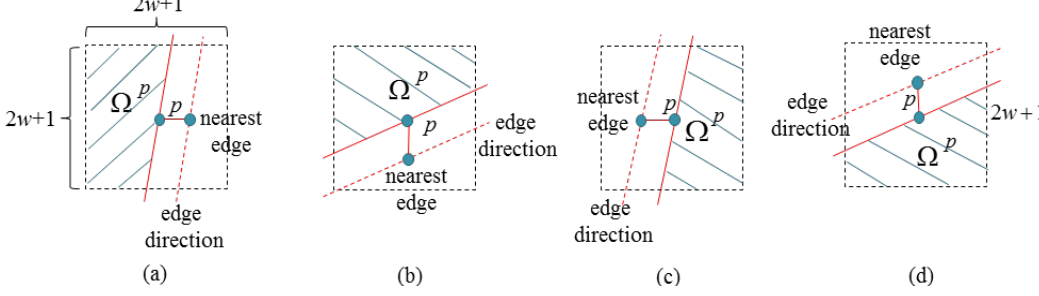
Figure 9. Filter range p  for ( a ) left to right; ( b ) top to bottom; ( c ) right to left; and ( d ) bottom to top directional hole